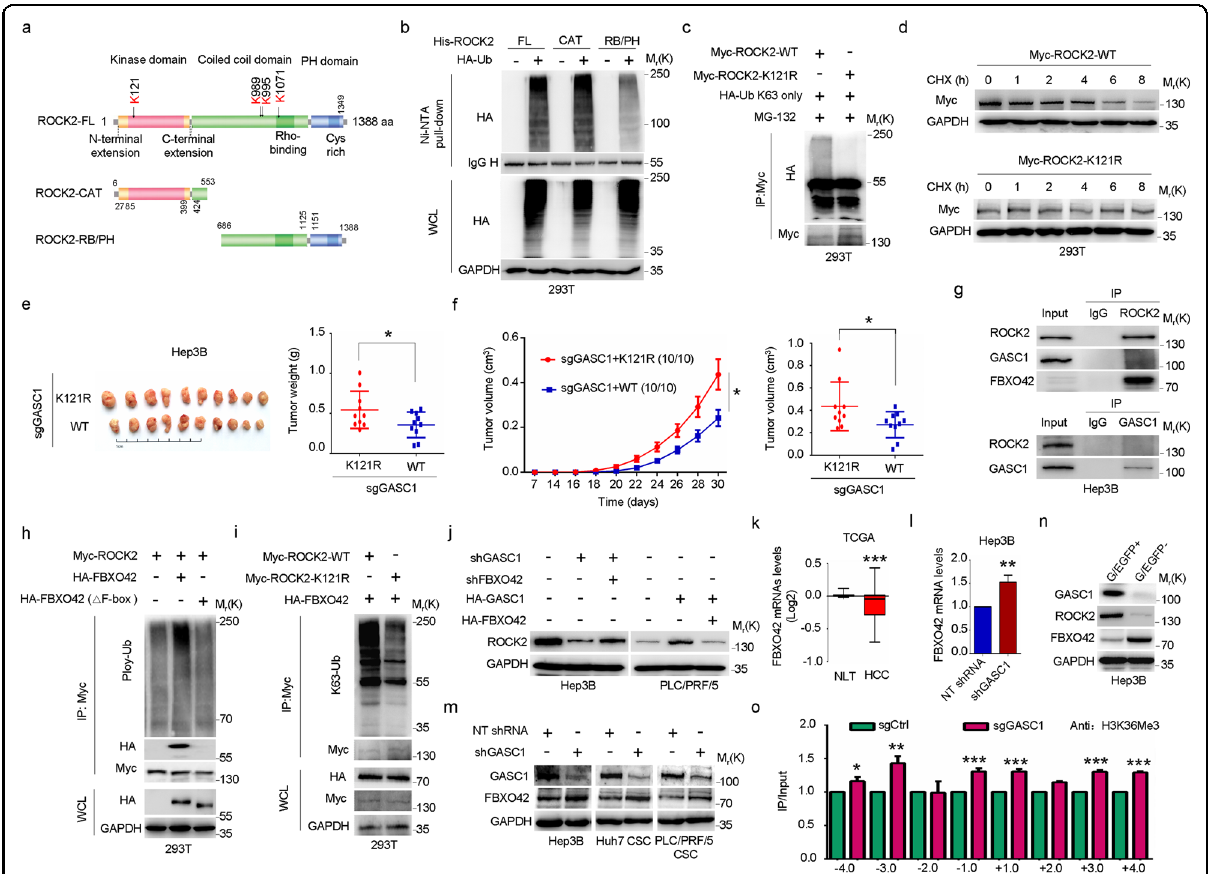
Fig. 5 GASC1 epigenetically represses FBXO42 expression to prevent ROCK2 K121 poly-ubiquitination and degradation. a Schematic of ROCK2 functional domains with potential poly-ubiquitination sites indicated. b CAT domain harbors the main poly-ubiquitination sites in ROCK2. Cells were treated with 10 μ M MG-132 for 8 h before harvesting. FL full length. CAT catalytic domain region. RB/PH Rho-binding/PH region auto- inhibitory domains. c Point mutation of K121 within the CAT domain abolishes ROCK2 poly-ubiquitination. Poly-ubiquitination of ROCK2 in HEK293T cells was examined by transfecting WT and K121R Myc-ROCK2 constructs together with HA-K63-linked ubiquitin, followed by IP and IB analyses. Cells were treated with 10 μ M MG-132 for 6 h before harvesting. d K121R mutation signi fi cantly extended the half-life of ROCK2